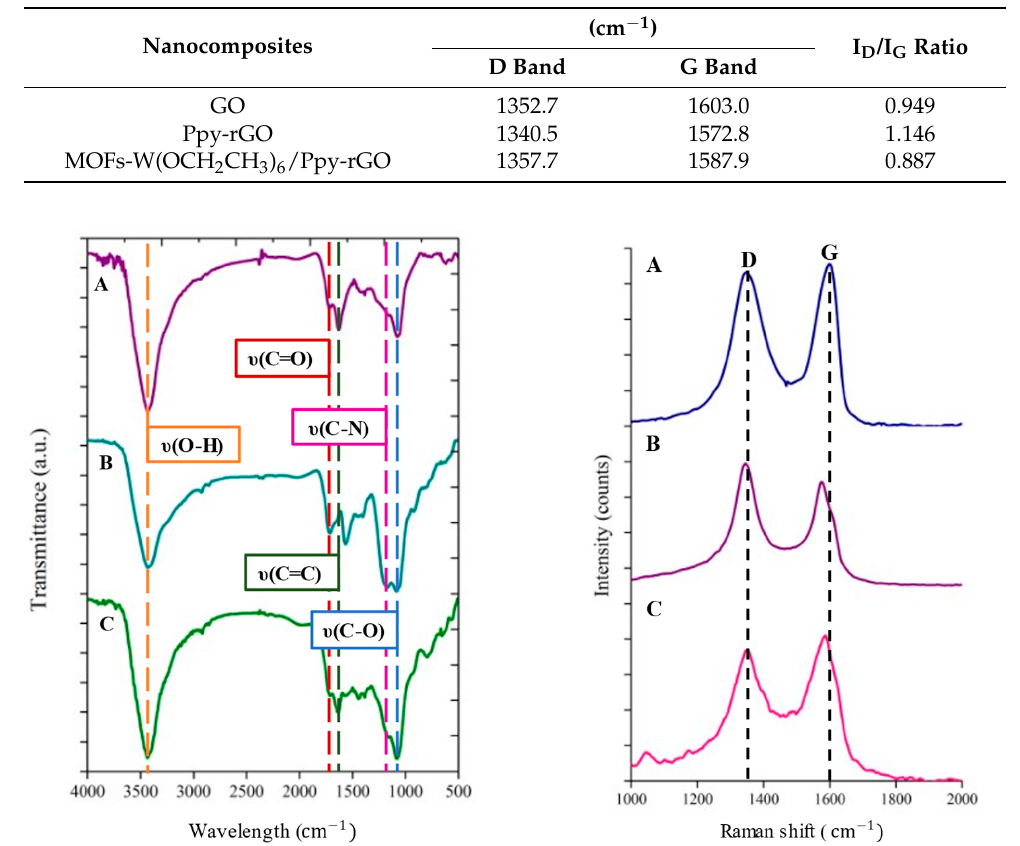
Table 1. Raman shifts and intensity ratios of GO, Ppy-rGO, and MOFs-W(OCH 2 CH 3 ) 6 /Ppy-rGO.